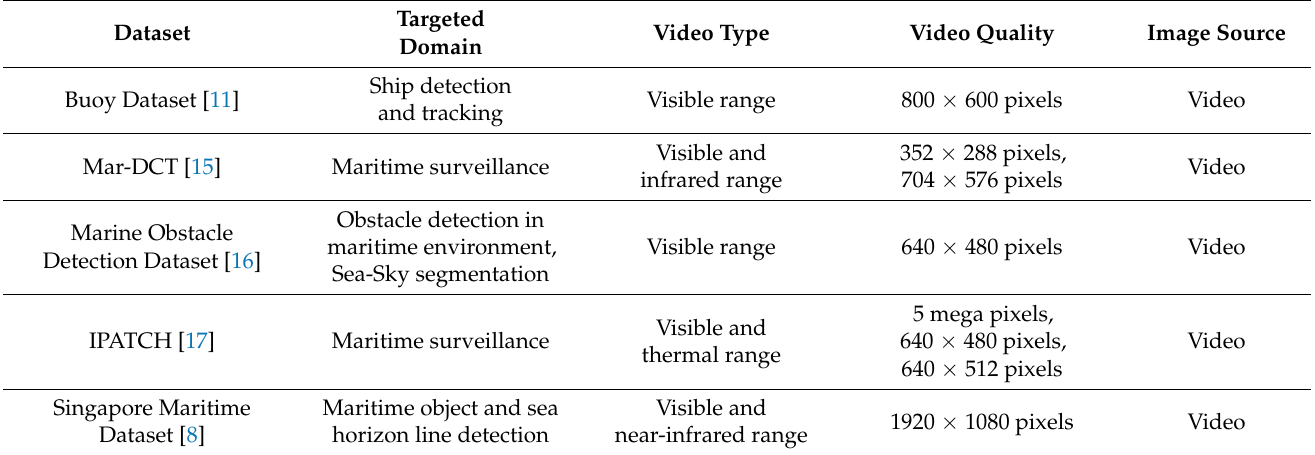
Table 1. Discussed dataset’s targeted domains and image